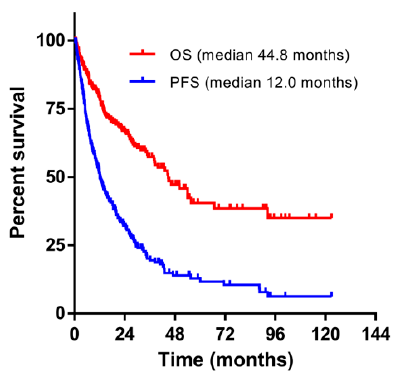
Figure 1. Overall survival (OS) and progression free survival (PFS) of all patients with first relapsed myeloma (n = 300).